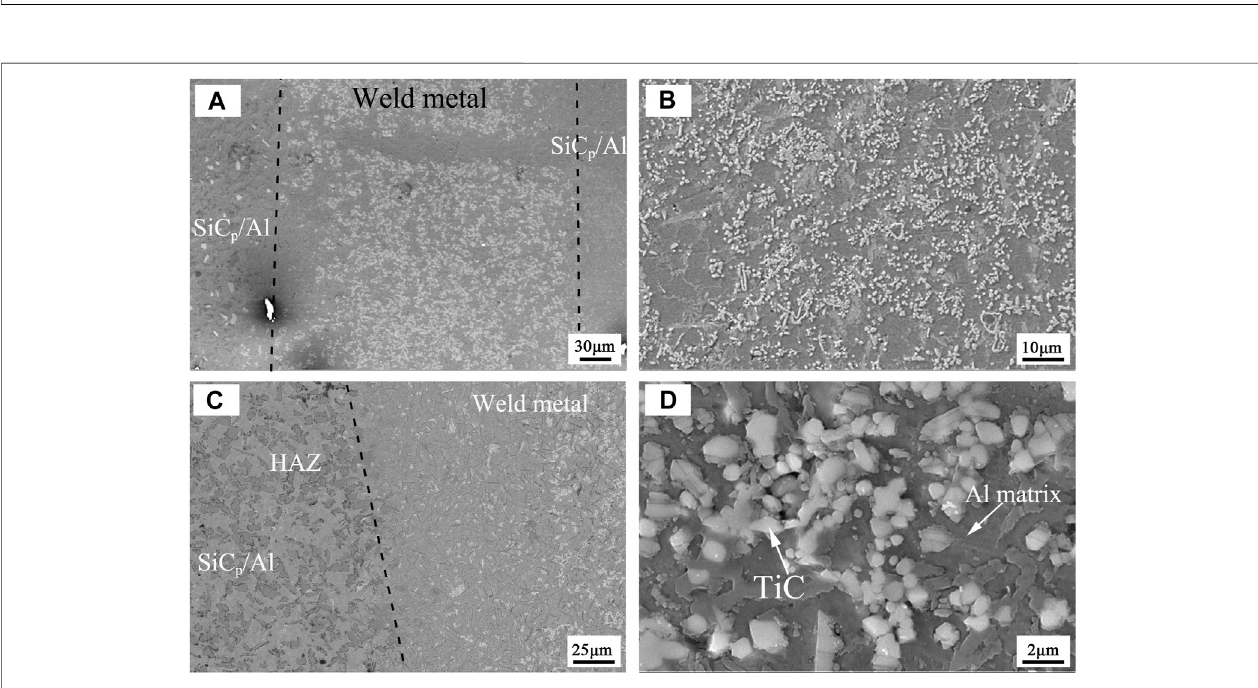
FIGURE 8 | SEM micrograph of SiC p /6061Al laser welding with Ti interlayer: (A) cross section of the joint (B) microstructure in the center of weld seam (C) microstructure at the interface between weld metal and base metal (D) TiC particles in the center of weld seam.